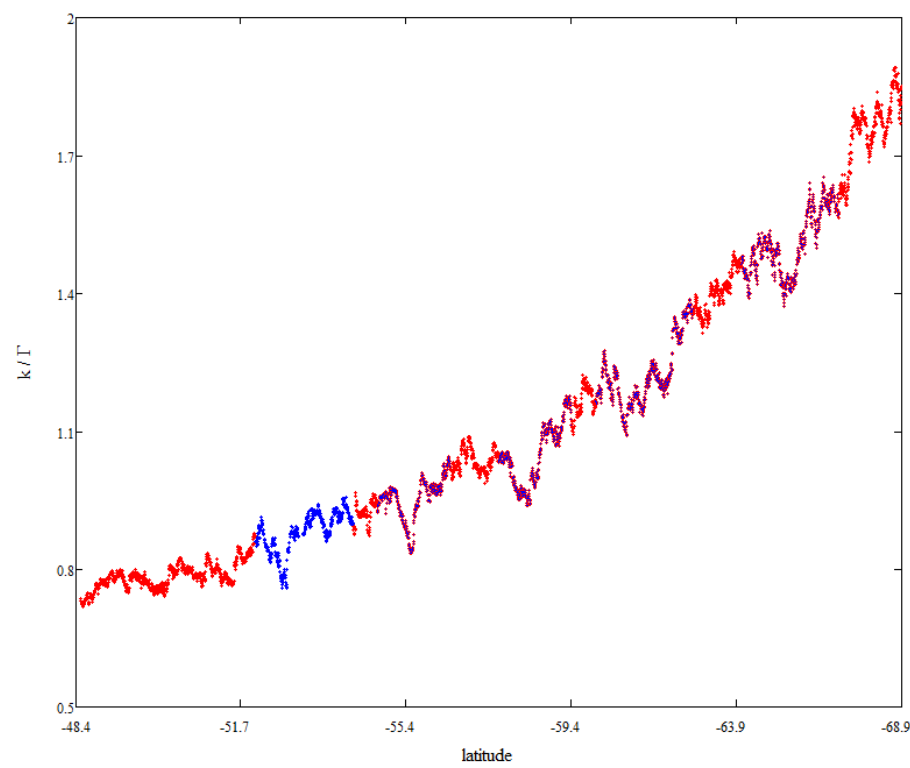
Figure 4. The ratio of the parameters k and Γ in the first 170 days of 1994. Calculations are performed using hourlyaveraged Ulysses data. The latitudes at which Ulysses waslocated at different points in time are marked (1st, 35th, 69th, 103th, 137th, and 171st days of the year 1994). All values of k/Г are highlighted in red; intersections of the regions with polar conic current sheets are highlighted in blue.